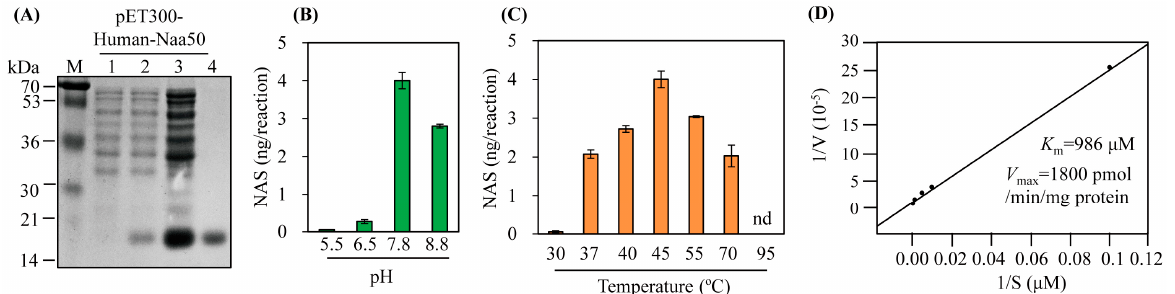
Figure 3. ( A ) Purification of N-terminal His × 6-tagged human Naa50. Serotonin N -acetyltransferase activity (conversion of serotonin into N -acetylserotonin [NAS]) as a function of ( B ) pH, ( C ) temper- ature, and ( D ) K m and V max values of human Naa50. E . coli BL21 (DE3) cells harboring the pET300- human Naa50 plasmid were induced with isopropyl β -D-thiogalactopyranoside (IPTG) for 5 h at 28 °C. M, molecular mass standards; lane 1, total proteins in 15 μ L aliquots of bacterial culture without IPTG.; lane 2, total proteins in 15 μ L aliquots of bacterial culture with IPTG.; lane 3, 20 μ g soluble protein; lane 4, 5 μ g protein purified by affinity chromatography. Protein samples were separated via 12% SDS-PAGE and stained with Coomassie blue. SNAT activity was measured based on N - acetylserotonin production in the presence of 0.5 mM serotonin at 45 °C and pH 7.8. K m and V max values were determined using Lineweaver-Burk plots. In vitro enzymatic products were measured via high-performance liquid chromatography (HPLC). Values are means ± SDs ( n = 3).